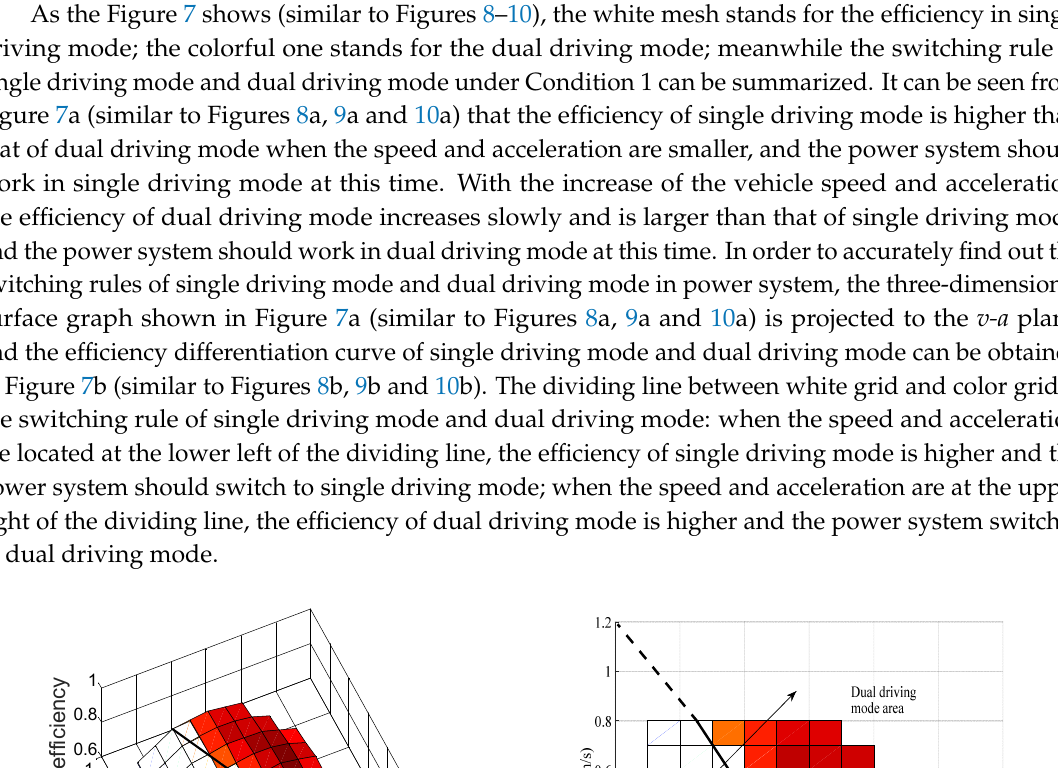
Figure 7. Efficiency comparison and switching rule under Condition 1. 213